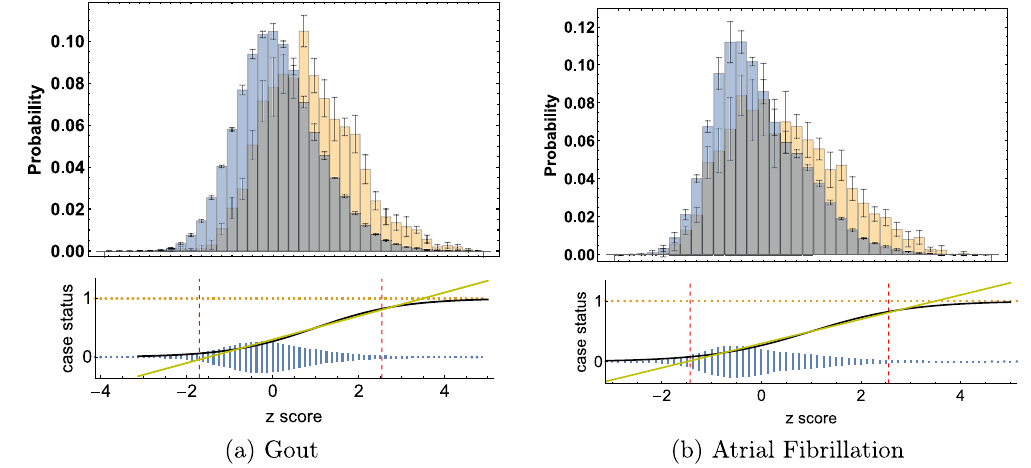
Figure 1. Top plots are histograms of controls (blue) and cases (gold). The bar heights are the averages over 5 AA testing runs. The error bars are standard deviations. On the bottom the same average case and control points are plotted on separate lines (1/0) for cases and controls. The height of the bars (gold and blue) represents the relative density of data points in that bin. Note that on the bottom, the gold and blue bars have been normalized using the same scale; the gold density looks small because most of the individuals in the data set are controls. The red dashed lines mark the 4% and 96% quartile of data, i.e. 92% of the data lies between those points. The x-axes are the same for top and bottom graphs: z scores, or number of standard deviations from the control mean. A linear (yellow) and logistic (black) curve are plotted over this range. It is clear that the difference between linear and logistic curves is negligible in the region where the data is